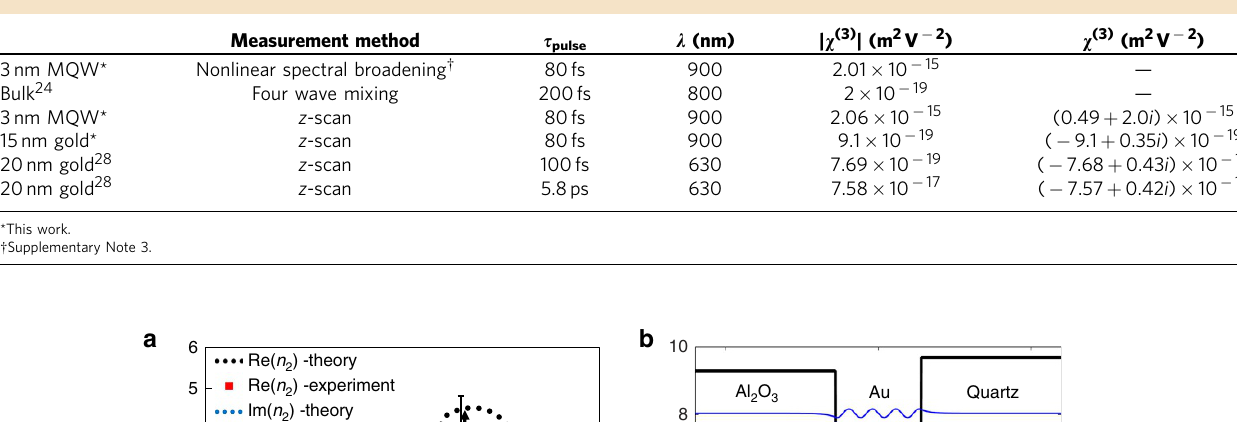
Table 1 | Comparison of the w (3) values of gold from different measurements.